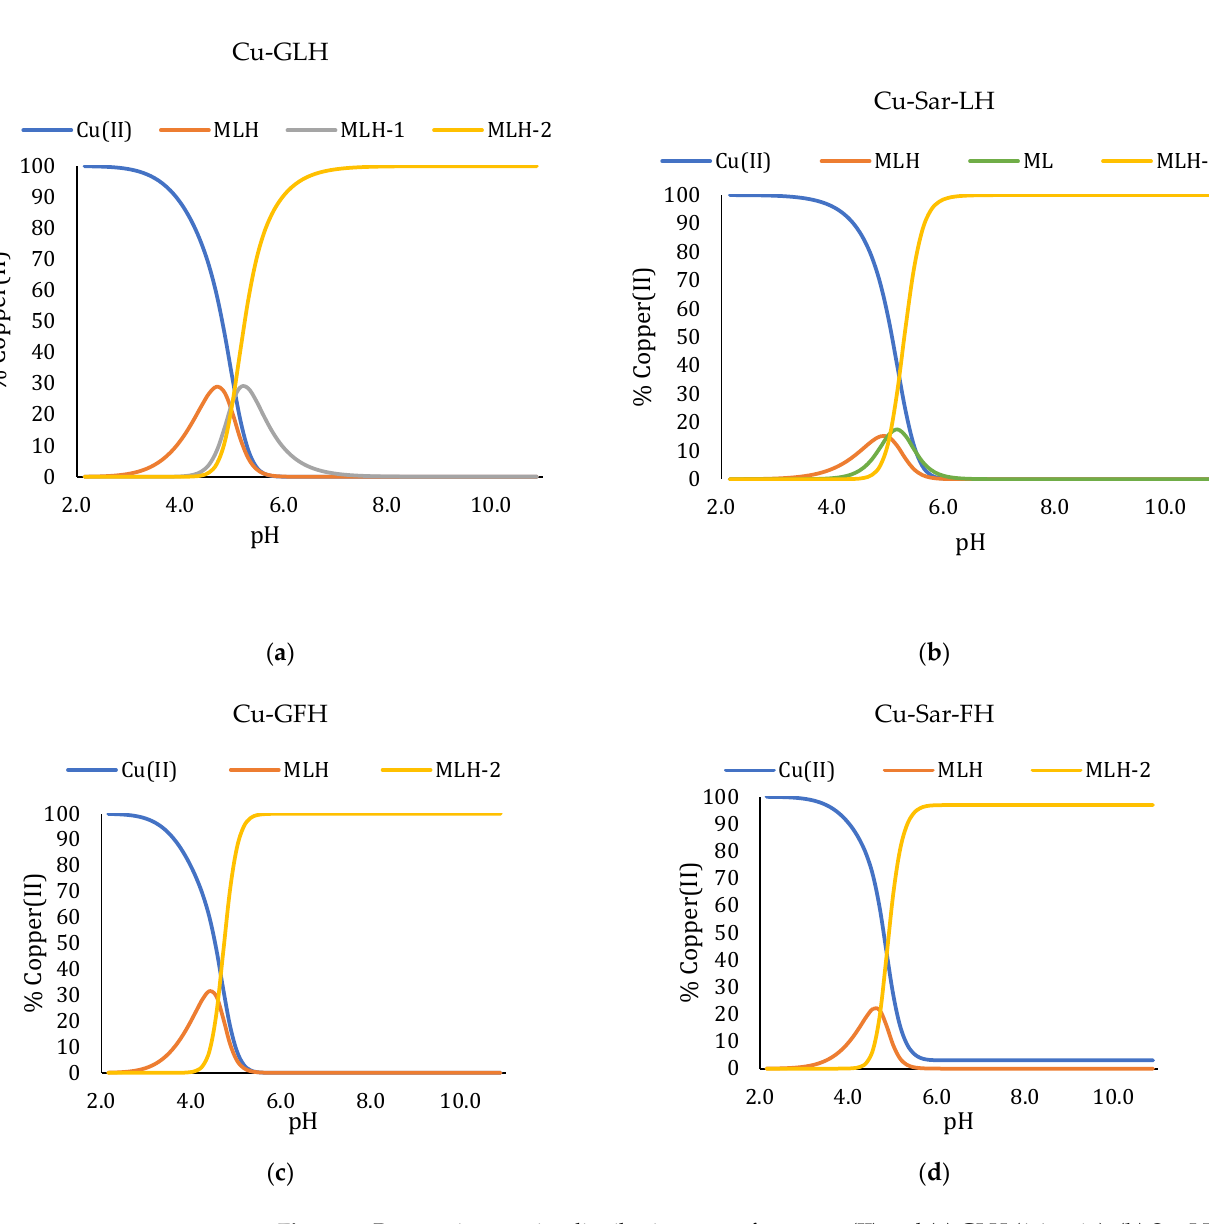
Figure 1. Protonation species distribution curve for copper(II) and ( a ) GLH (1:1 ratio), ( b ) Sar-LH (1:1 ratio), ( c ) GFH (1:1 ratio) and ( d ) Sar-FH (1:1 ratio) at 25 °C in 0.15 mol dm −3 (NaCl).